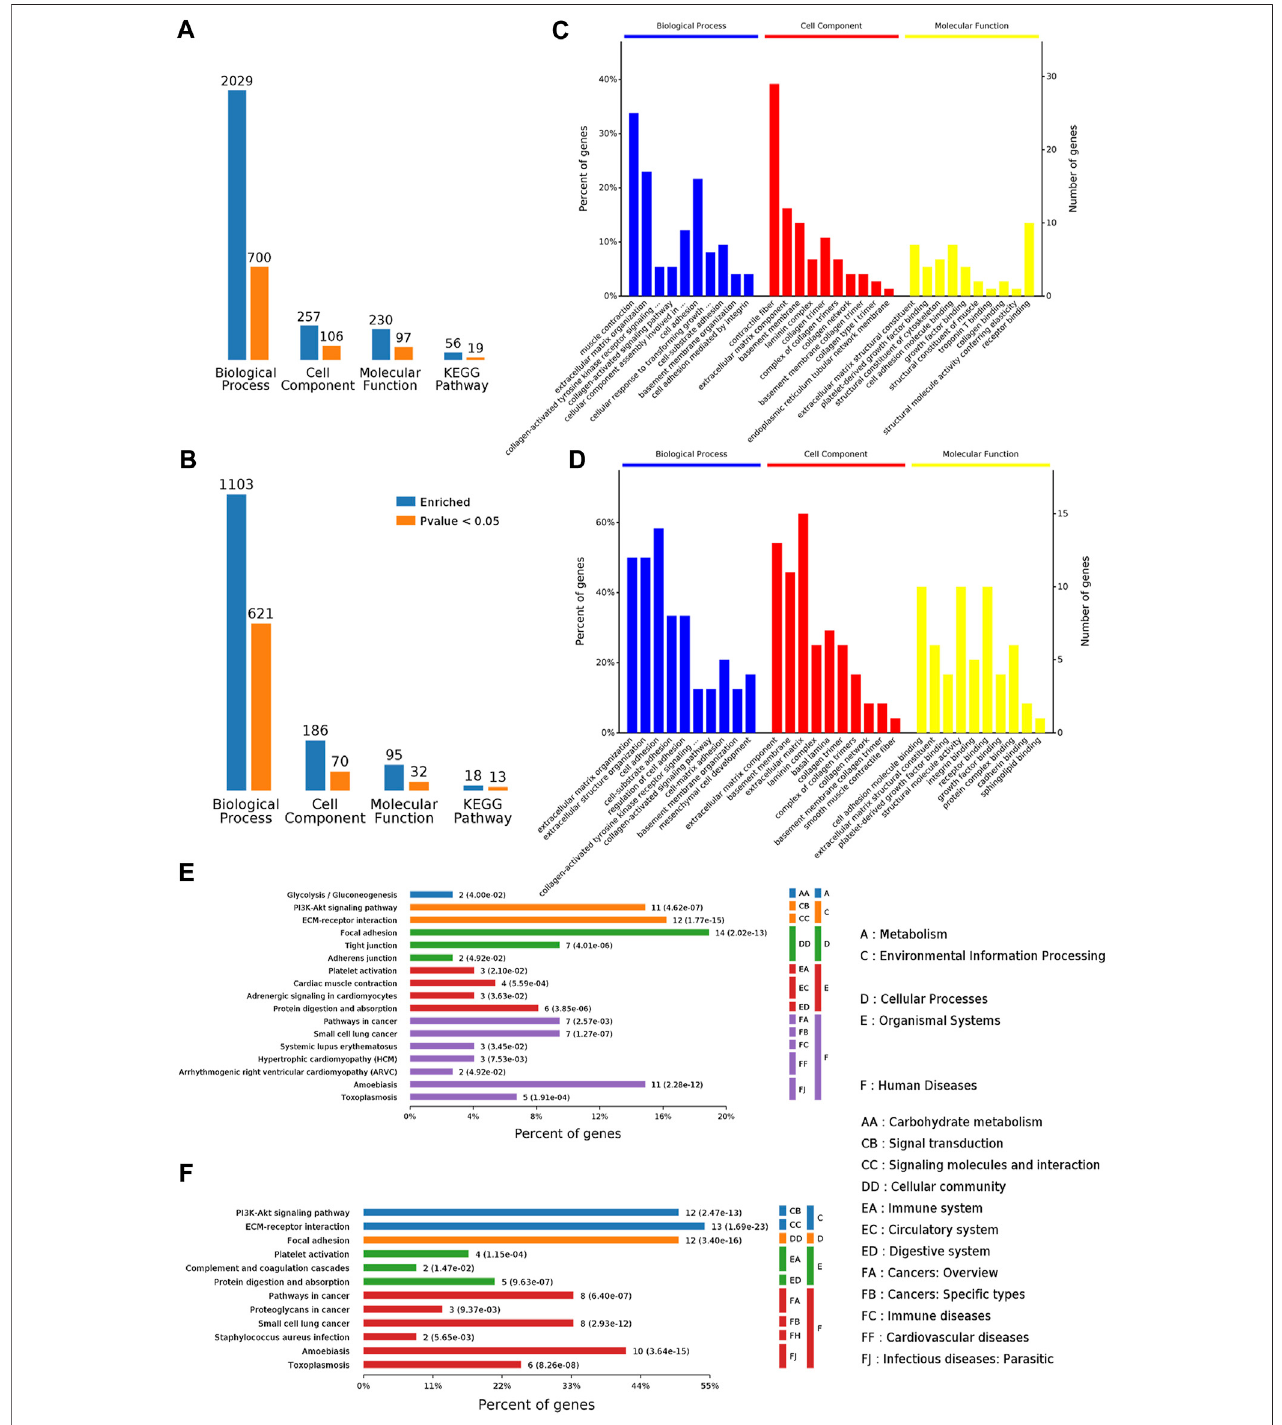
FIGURE5| FunctionalannotationandcategoriesofDAPs. (A – B) BioinformaticsanalysisofDEPsbycategories:BP,CC,MF,and KEGGpathway, respectively(A: Model/Control, B: GBFXD/Model). Counts for each category represent the total associated terms in the database with the query protein list. Terms are statistically signi fi cant with a p -value < 0.05. (C – D) The ten most signi fi cantly enriched terms of the GO hierarchy, information of percentage, and number of involved proteins in a term are shown in the left and right y -axes, respectively (C: Model/Control, D: GBFXD/Model). (E – F) Enriched KEGG pathways of DAPs (E: Model/Control, F: GBFXD/Model). The number of involved proteins and corresponding p -values are shown on the right side of the column.